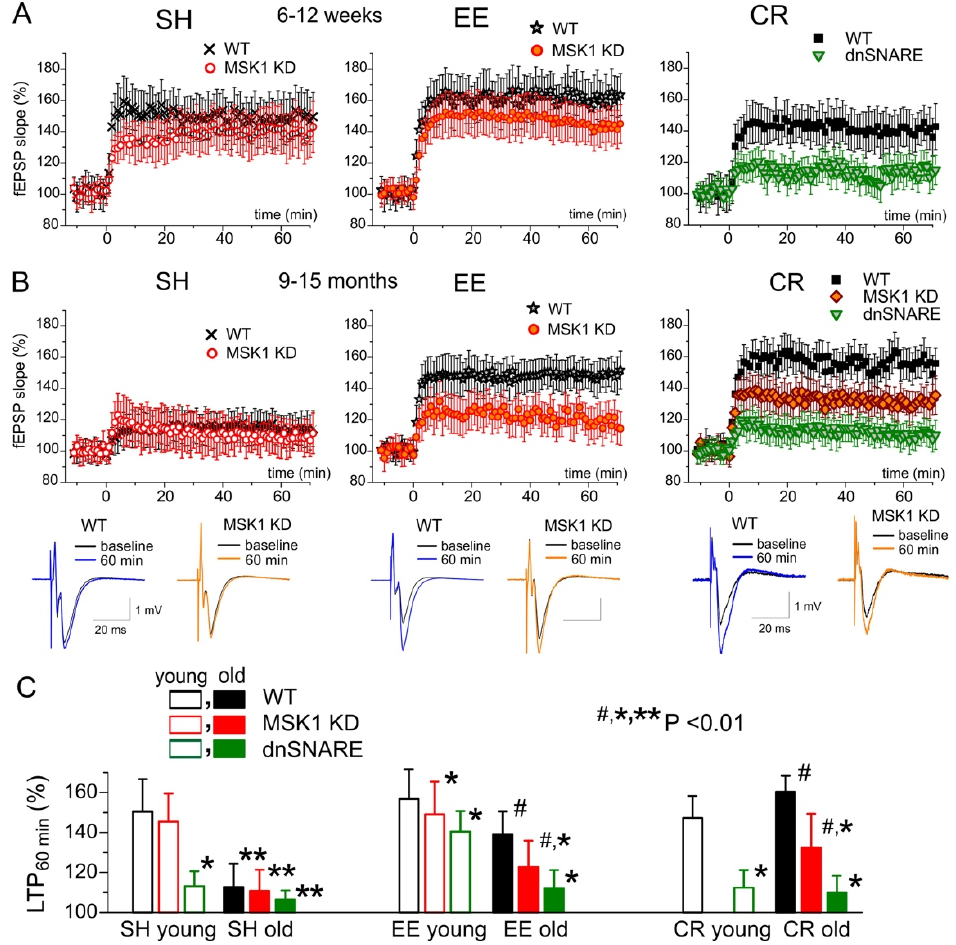
Figure 6. Impact of BDNF/MKS1 pathway and gliotransmission on synaptic plasticity in the neocortex. Long-term potentiation of field EPSPs (LTP) was induced in the layer 2/3 of somatosensory cortex of the wild-type, MSK1 KD and dnSNARE mice as described in the Methods section. ( A , B ) The time course of changes in the fEPSP induced by 50 HFS trains delivered at zero time, measured in the young ( A ) and old ( B ) mice of standard housing (SH) and mice exposed to enriched environment (EE) and caloric restriction diet (CR). Dots in the graphs represent the average of 6 consecutive fEPSPs; data are shown as mean ± SD for 7–15 experiments. Data were normalized to the fEPSP slope averaged over 10 min period prior to the HFS. The insets show the average fEPSP waveforms recorded in old mice before and 60 min after the HFS. ( C ) The pooled data on the magnitude of the long-term potentiation of the neocortical fEPSP in young and old mice of di ff erent genotypes at di ff erent conditions. Graphs show the magnitude of LTP evaluated as relative increase in the fEPSP slope at 60th min, averaged across 10 min time window and plotted against the number of HFS trains delivered. Data are shown as mean ± SD for the following number of experiments (mice used): 10–15 (7–10) for SH, 7–10 (4–5) for EE and 7–9 (4–5) for CR mice. The statistical significance (2-population unpaired t -test) for the di ff erence between genotypes, age- and treatment groups was indicated by di ff erent symbols as follows: (#)—e ff ect of EE or CR as compared to SH mice of the same genotype; (*) dnSNARE mice vs. their WT litter-mates of the same age and housing; (**) old vs. young mice of the same genotype and housing. Note the significant decrease in the LTP magnitude in old mice and significant e ff ects of EE and CR in the old WT